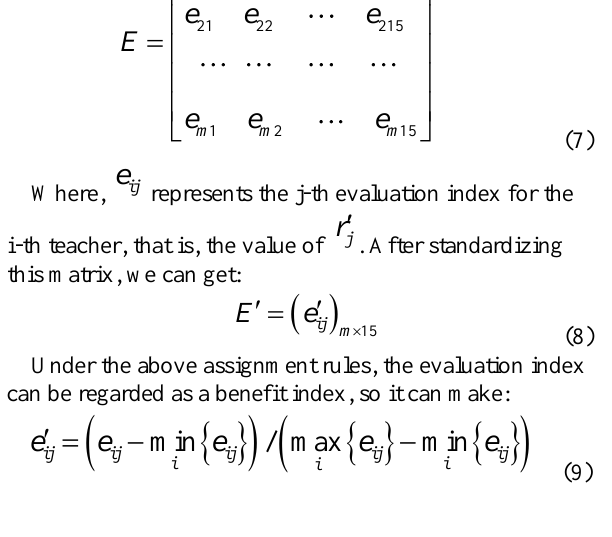
Table 4. Evaluation indexes and evaluation objects Evaluation